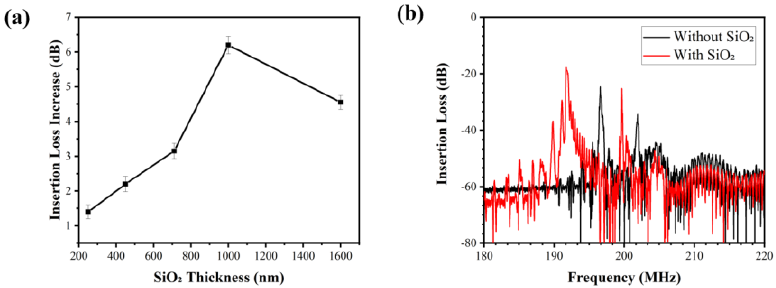
Figure 3. ( a ) The variation in insertion losses of the SAW device with various thicknesses of SiO 2 (three repetitions were performed); ( b ) S21 transmission spectra for the SAW device with and with − out 1000-nm-thick SiO 2 .